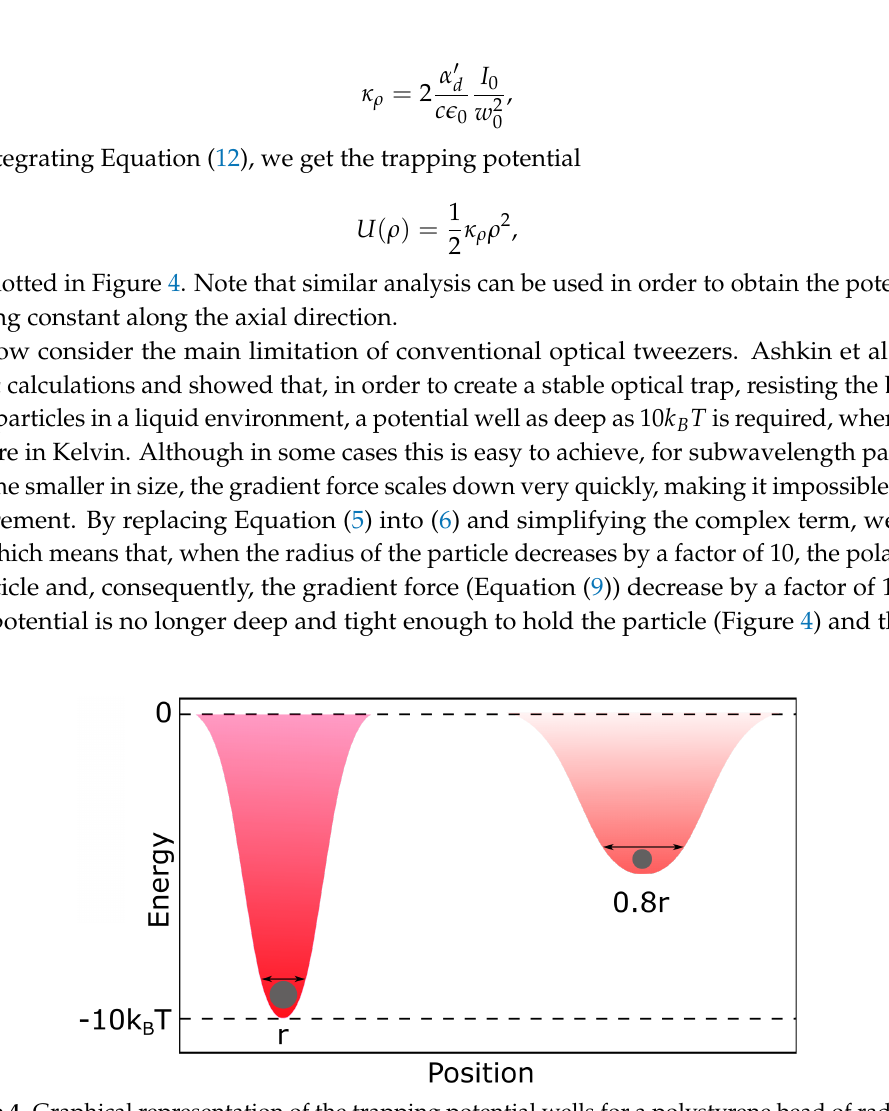
Figure 4. Graphical representation of the trapping potential wells for a polystyrene bead of radius r and 0.8 r . A small decrease in the particle’s size creates a significantly shallower and broader trapping potential well, which offers much weaker confinement and, thus, the particle has a higher probability to escape from the